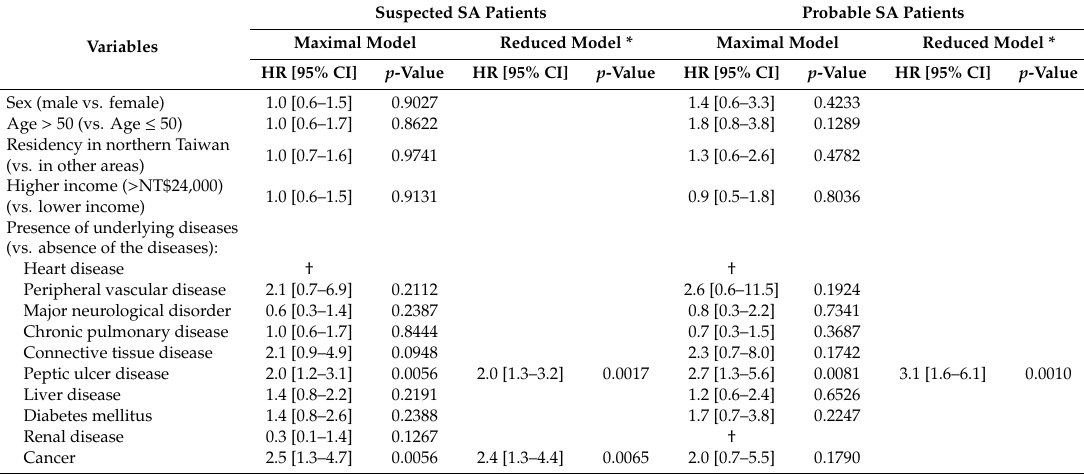
Table 3. Multivariable Cox regression analyses of the factors contributing to temporomandibular disorder (TMD) in SA patients.